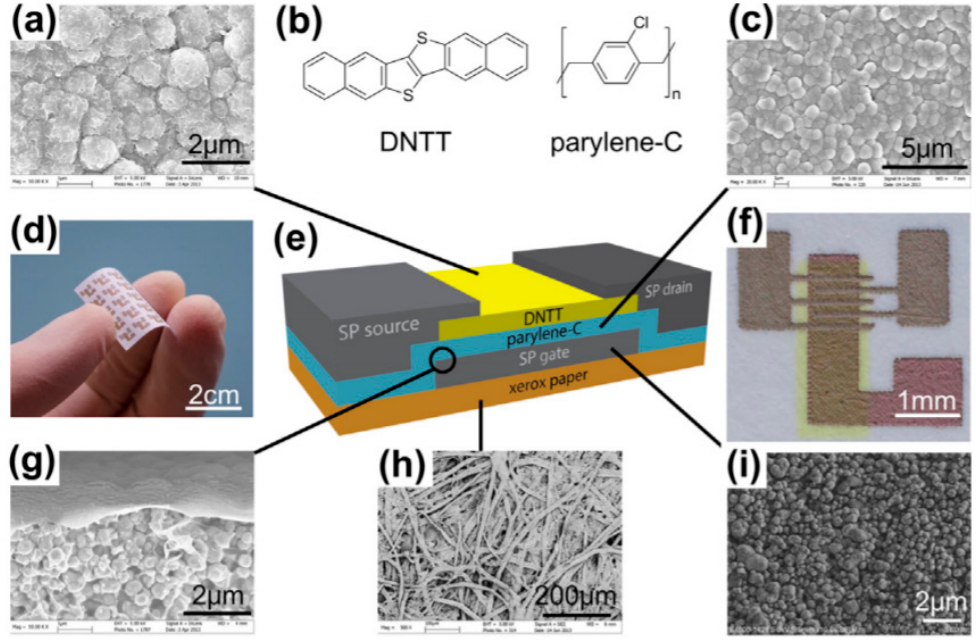
Figure 42. ( a ) SEM image of the semiconducting DNTT (dinaphthothienothiophene) surface. ( b ) Chemical structure of DNTT and of the parylene-C dielectric. ( c ) SEM image of parylene-C surface. ( d ) Picture of 5 × 5 transistor matrix on Xerox paper. ( e ) Scheme of the whole transistor on paper. Source, drain and gate are scree-printed. ( f ) Picture of a single transistor on paper. ( g ) SEM cross-view of the parylene-C layer on top of the gate. ( h ) SEM picture of the paper surface. ( i ) SEM image of the gate surface. Adapted from [169], copyright 2014, with permission from Elsevier.